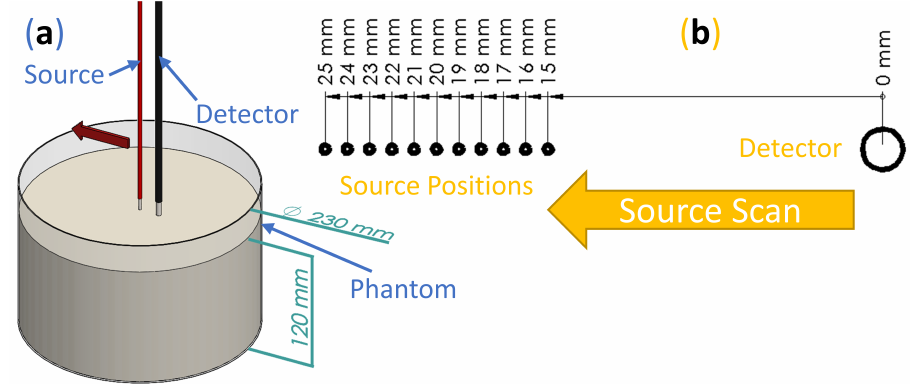
Figure 1. Frequency-domain near-infrared spectroscopy methods to achieve measurements of absolute optical properties. ( a ) Render of multi-distance scan done on diffuse optical phantoms. ( b ) Schematic of eleven different source positions realized during the multi-distance